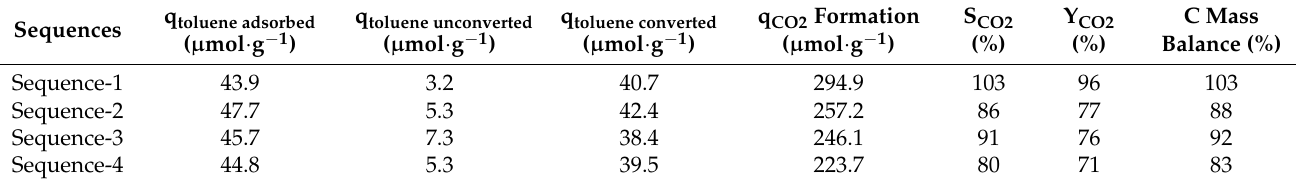
Figure 4. Temporal profiles of toluene during adsorption ( a ), desorbed toluene during NTP exposure ( b ), CO 2 evolution during NTP exposure, ( c ) over the 4 sequences. Table 4. Characteristic properties of the APC process over the 4 sequences.